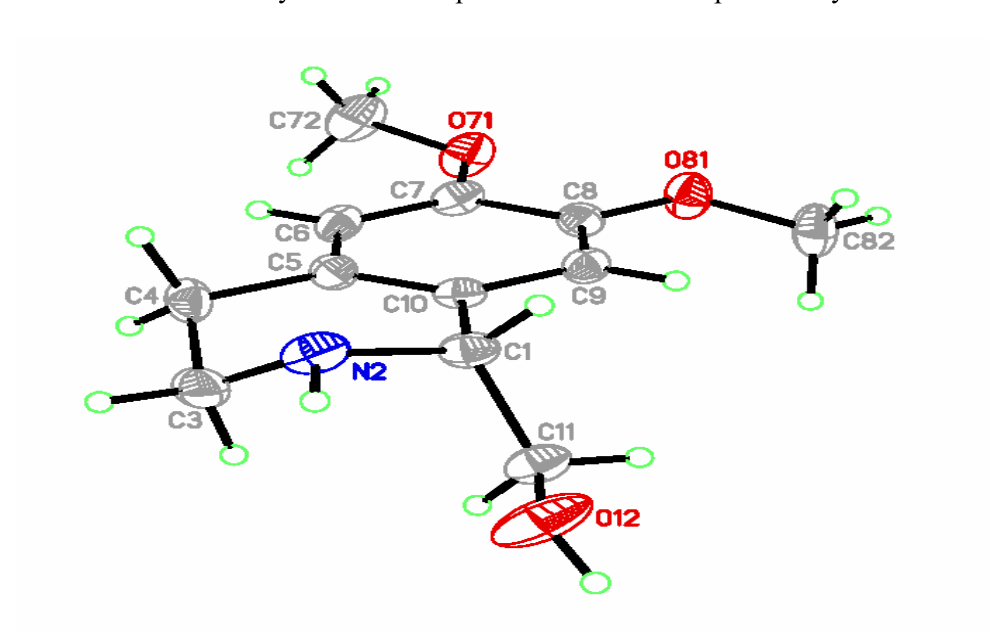
Figure 1. ORTEP view of 1 showing the atomic labeling scheme, with H atoms removed for clarity. Thermal ellipsoids drawn at 50% probability levels.